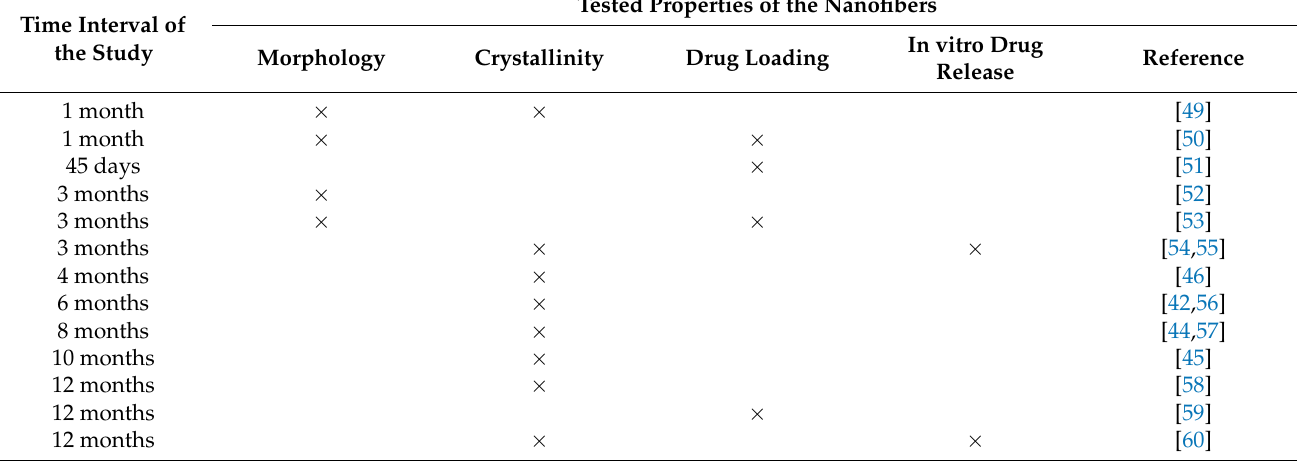
In vitro Drug Release